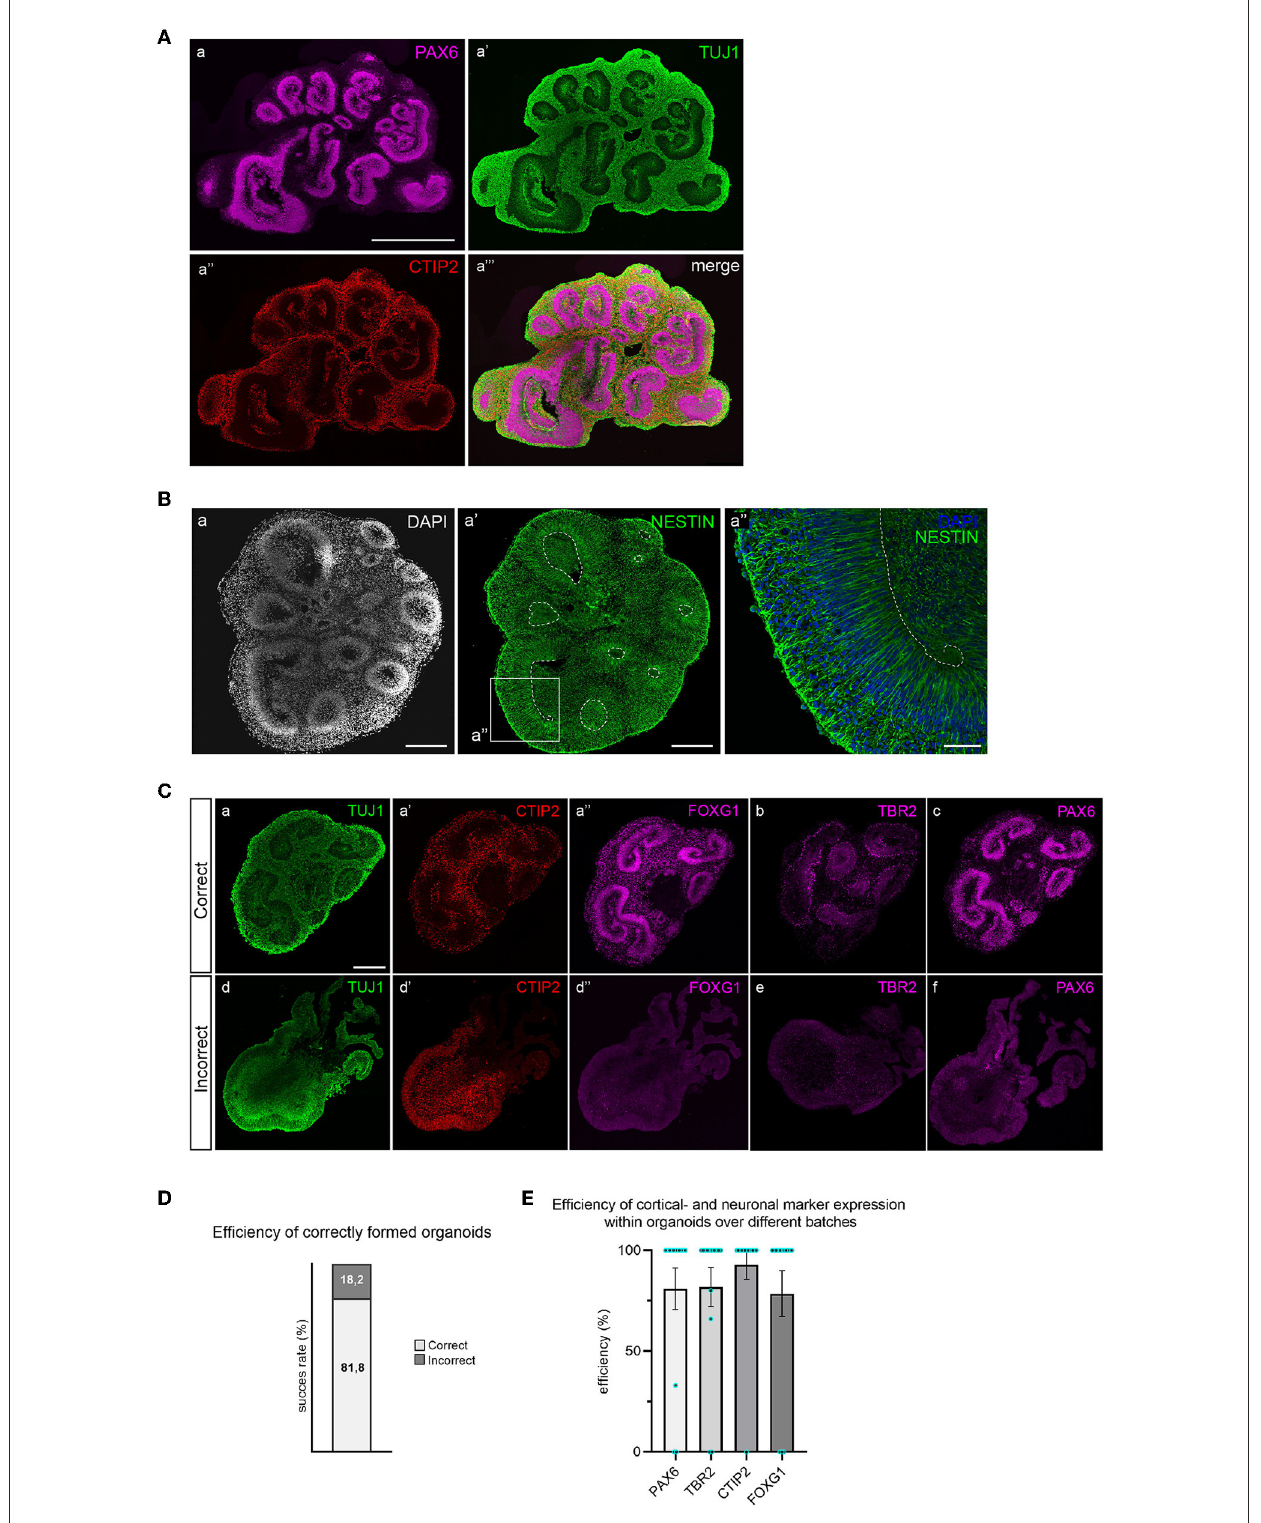
FIGURE4 Immunofluorescent staining for brain regions and neuronal cell types in 35-day old cortical organoids. (A) Multiple PAX6 + progenitor zones are distributed throughout the organoid in the shape of large folds or small rosettes, and surrounding ventricle-like cavities. Whereas progenitor zones are negative for TUJ1 (class-III tubulin), early neuronal differentiation outside of progenitor zones is marked by abundant TUJ1 expression. Early-born deep-layer neurons (CTIP2) reside outside of progenitor zones. Scalebar: 1mm for all panels. (B) Apical radial glial cells (NESTIN + ) occupy progenitor zones and extend from the apical to the basal surface (panel a ′′ ). Scalebar a, a ′ : 250 µ m, a ′′ : 50 µ m. (C) Correctly formed organoids show structured progenitor zones (panel a), presence of deep-layer neurons (CTIP2, panel a ′ ), and expression of dorsal forebrain markers FOXG1, TBR2, and PAX6 (panels a ′′ , b, and c). Incorrect organoids lack organized progenitor zones (panel d), contain dispersed deep-layer neurons (panel d ′ ), and show absence of dorsal forebrain progenitor markers (panels d ′′ , e, and f). Scalebar: 250 µ m for all panels. (D) Batch efficiency of brain organoid differentiation. (E) Efficiency of cortical identity